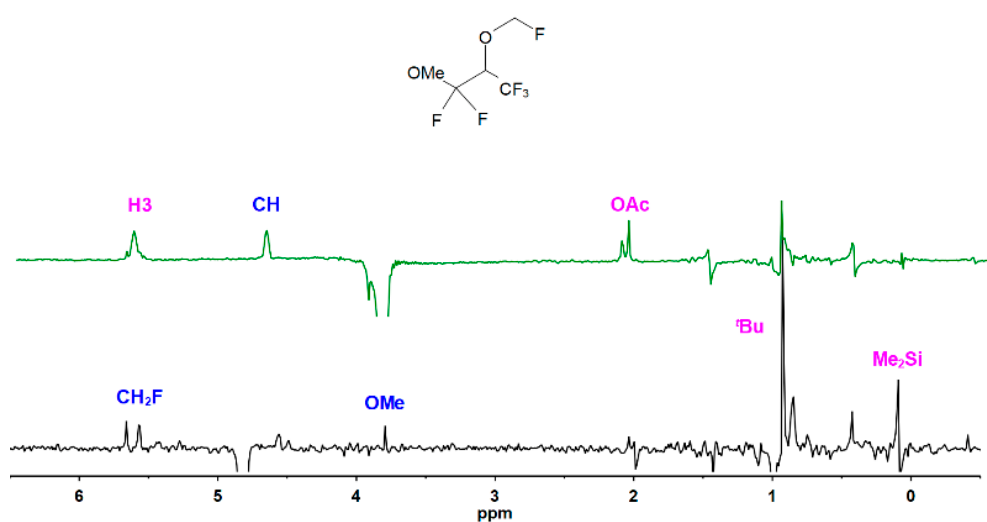
Figure 2. 2D ROESY (600 MHz, C 6 D 12 , 25 °C, mixing time = 600 ms) traces of the methine (black) and OMe (green) protons of compound B (60 mM) in a 1:1 mixture with AcSiCD8. The magenta protons belong to the host, the blue to the guest.